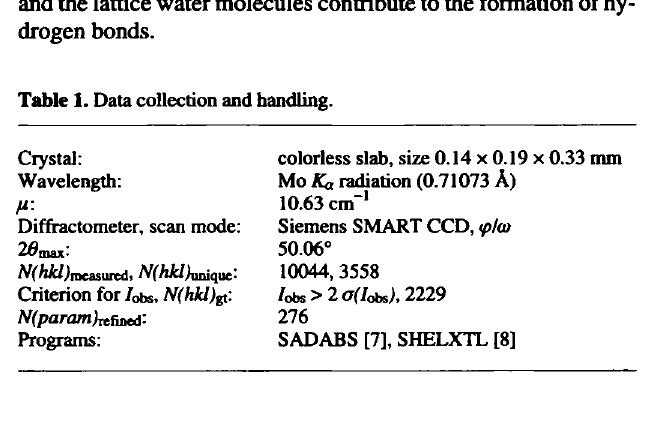
Table 1. Data collection and handling.